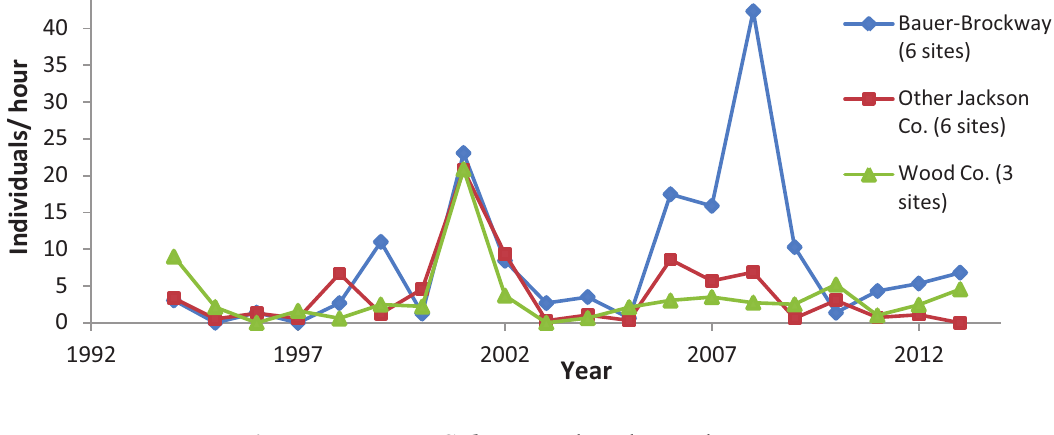
Figure 7. Mean C. henrici abundance, by county.